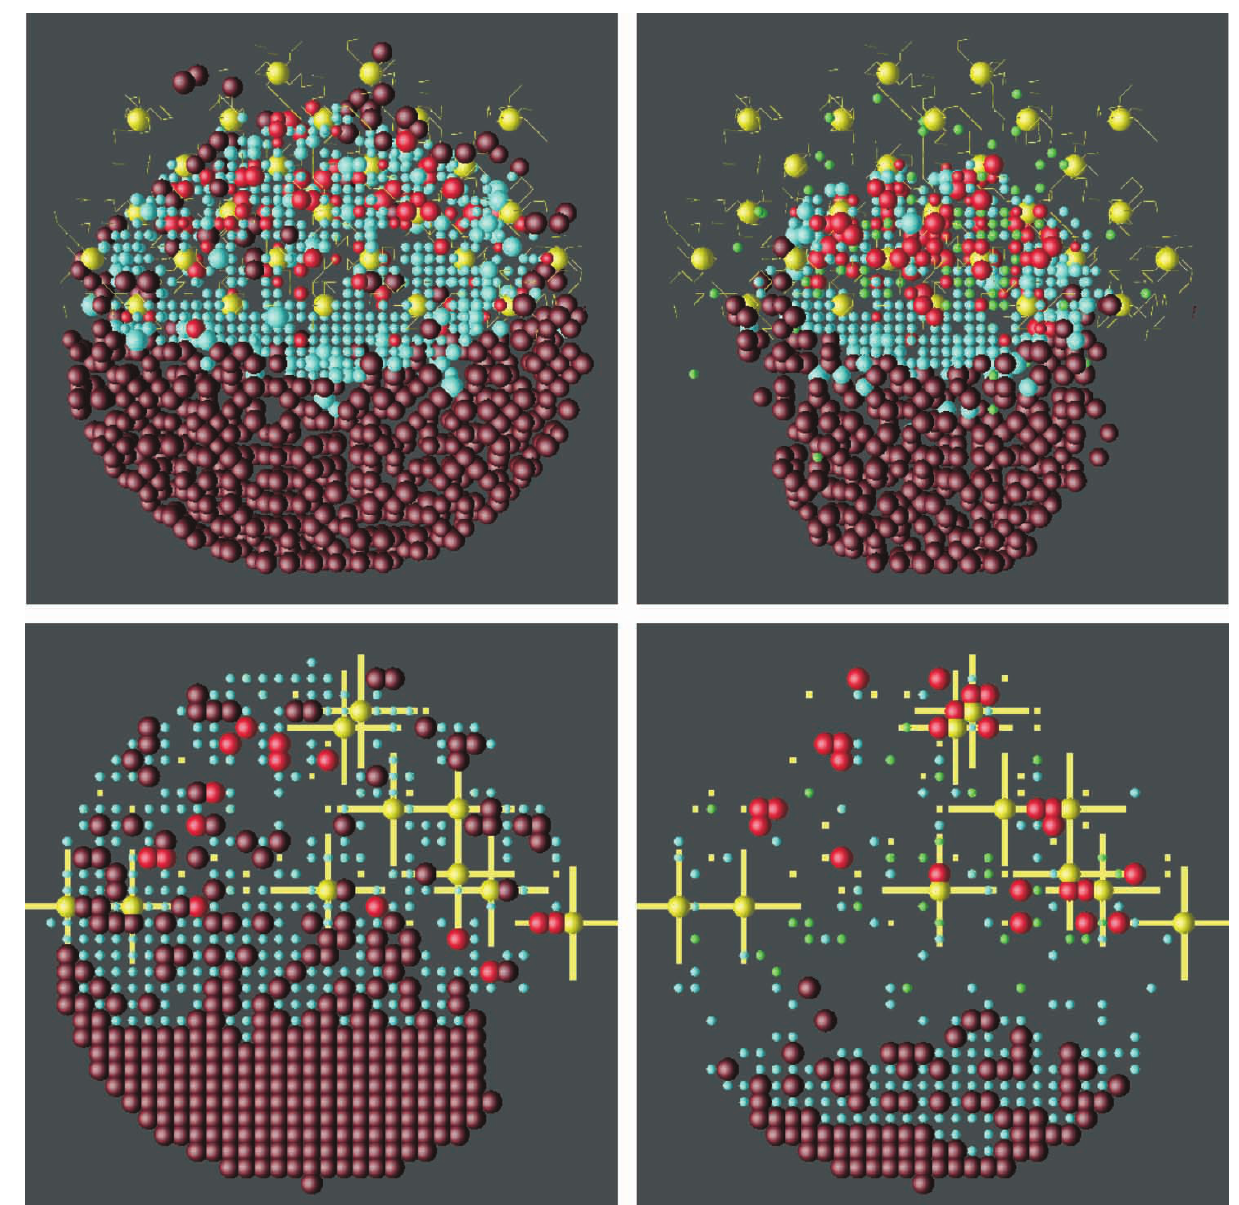
FIGURE 7 Comparing sections through GCs in the signaling and the chemotaxis model: a GC simulation (day 4 and 8, upper row) using the chemotaxis model, with a FDC-derived chemotactic signal acting on centrocytes (blue) and weakly on centroblasts (dark red), and with a centroblast differentiation signal diffusing on the GC volume (upper row). The unphysiological gap (see Fig. 6) has vanished. These sections compare to the ones generated with the signaling model (lower row) based on the same parameter set (see Table I, (s2)). Recycled centroblasts (light red) are found in the light zone; plasma- and memory cells (green); FDCs